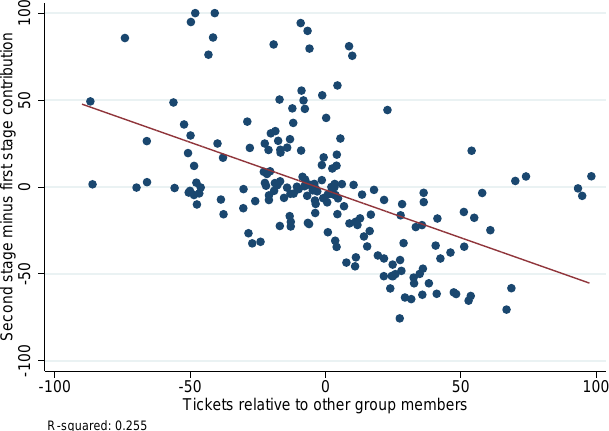
Figure 5. Regression to the mean